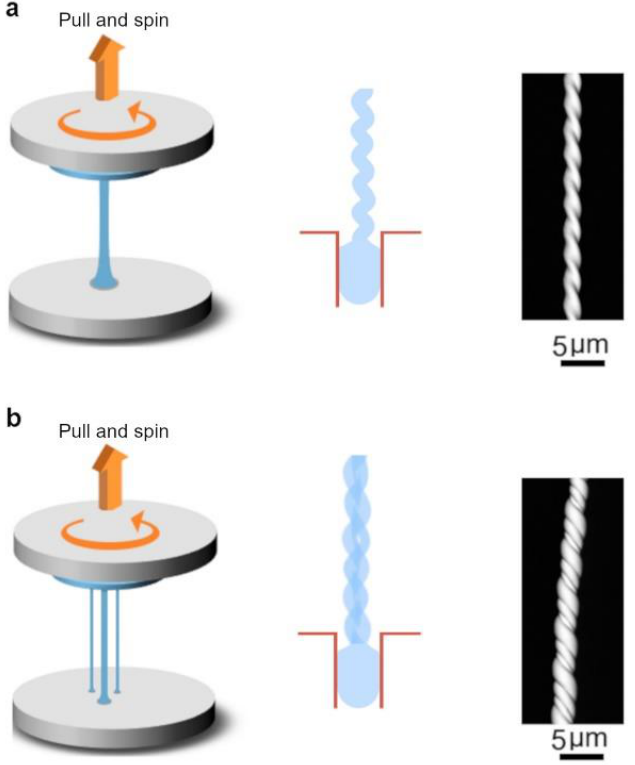
Figure 10. Fabrication of helical BMG fibers by thermoplastic drawing. ( a ) A single helical structure is formed by spinning the BMG fiber during drawing. The SEM image shows Pt-BMG helical microfiber formed by this approach. ( b ) BMG rope is formed by drawing and spinning multiple fibers. The SEM image shows Pt-BMG rope formed by drawing and spinning of three microfibers.